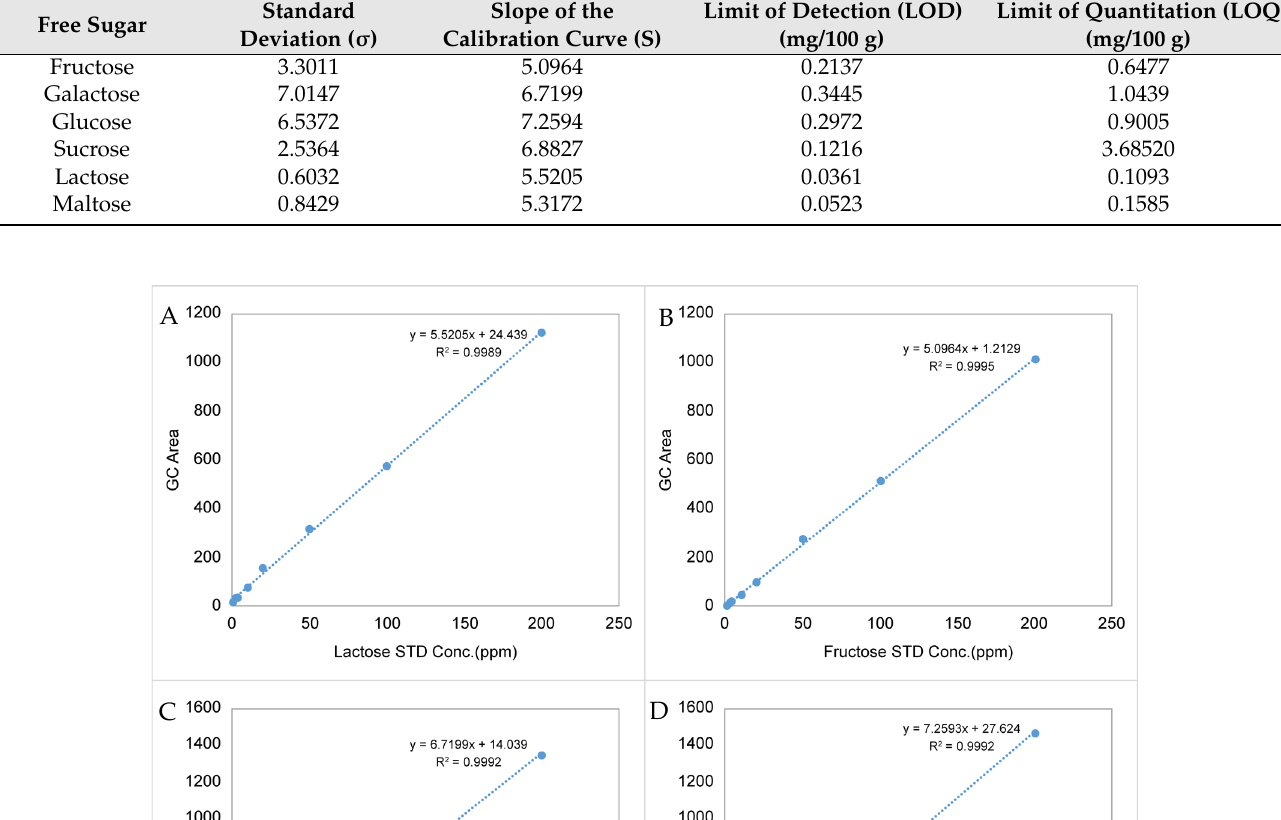
Table 2. LOD and LOQ of GC/FID for six major free sugar standards.